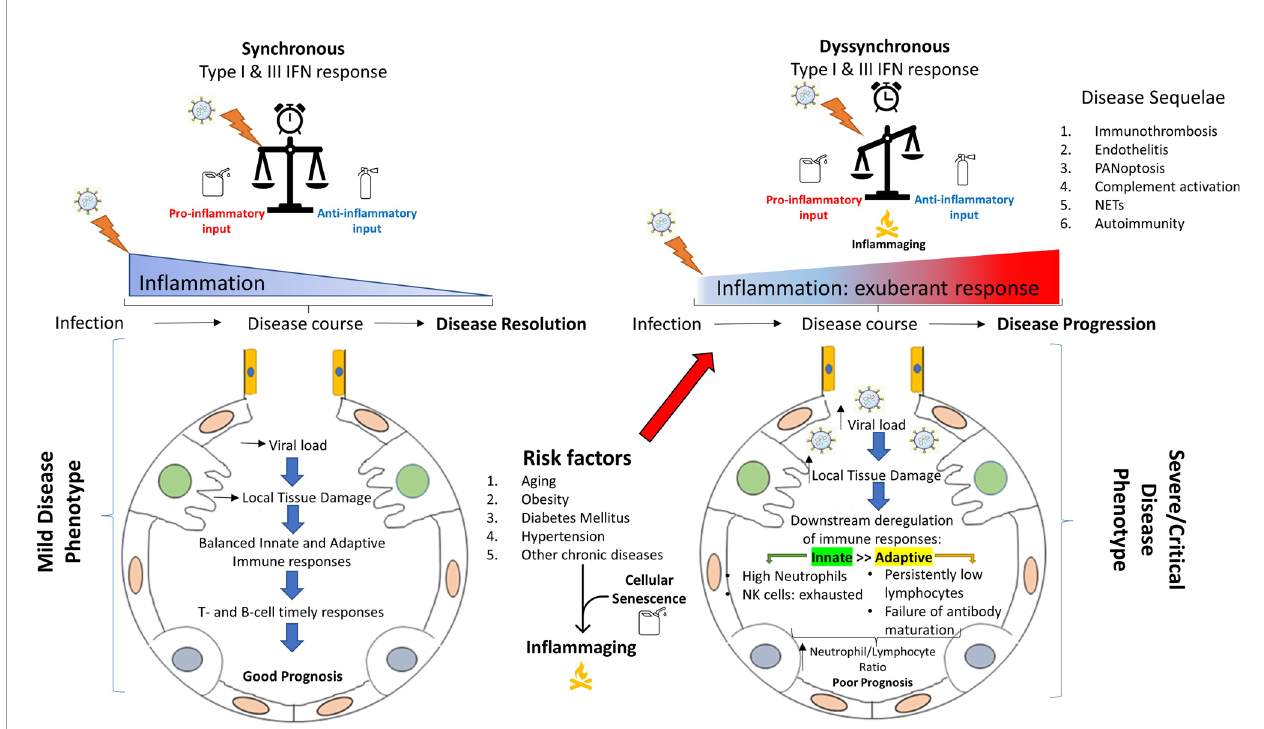
FIGURE 8 | Immunopathological differences between mild versus severe COVID-19. A well organized and spatiotemporally synchronized immune response (left), results in viral clearance and disease resolution through collaborative action of innate and adaptive immunity. To the contrary, in severe COVID-19, a series of risk/ predisposing factors (like age, obesity, hypertension, diabetes mellitus, cellular senescence etc.) in addition to other still unknown factors, leads to a spatiotemporal deregulation of the immune response (right). Subsequently, this deregulation can result in aberrant and sustained in fl ammation with multisystemic effects (cytokine deregulation, immunothrombosis, endothelitis, in fl ammatory cell death, NET production and release, complement activation, autoimmune phenomena etc.), leading to severe disease or even death. NET, neutrophil extracellular